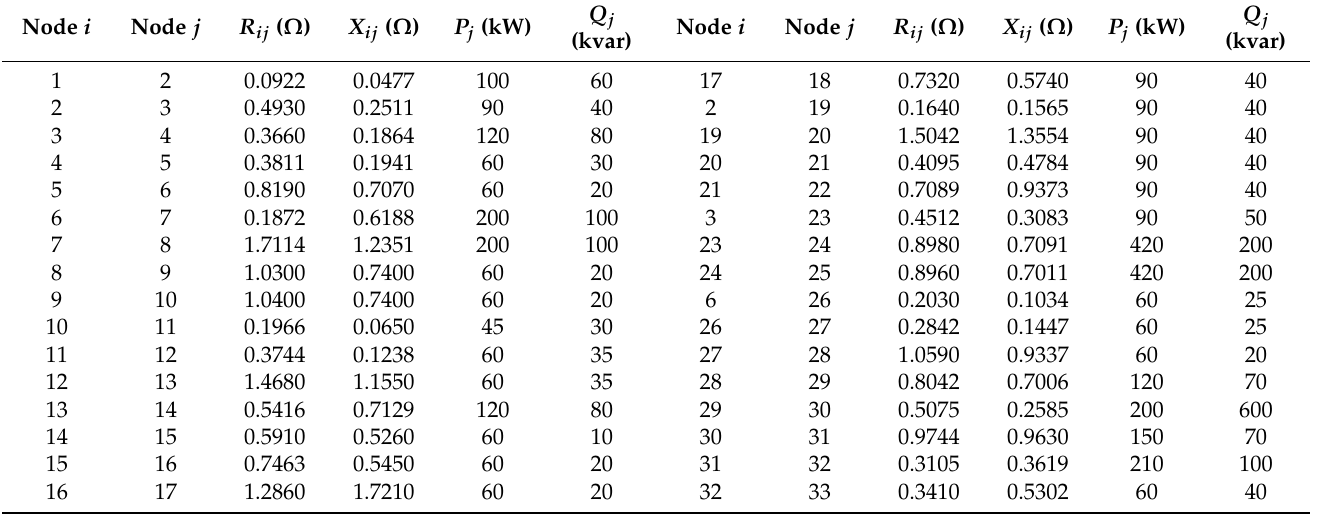
Table 2. IEEE 33-bus system